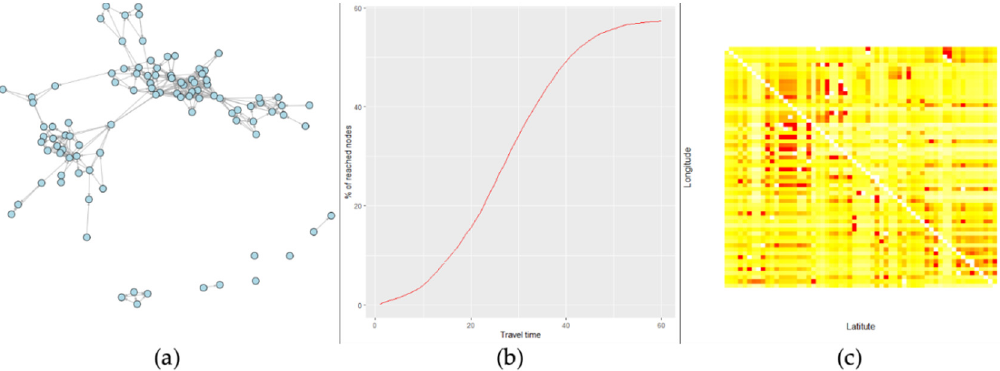
Figure 4. Spatial graph settings: ( a ) graph for the 10-min neighborhood; ( b ) percentage of achievable nodes within specified travel time (min); and ( c ) spatial graph Laplacian’s heat map, ordered by geographical coordinates.